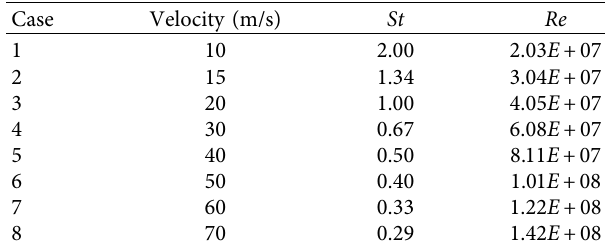
Table 1: Parameters of the